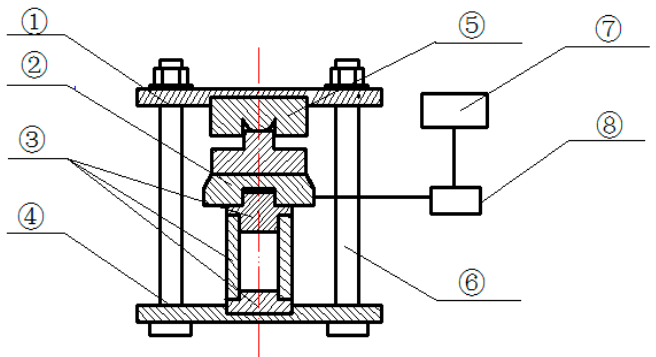
Figure 1. Schematic diagram of the expansion stress test apparatus: ① top plate, ② sensor, ③ sample mold, ④ bottom plate, ⑤ anti-load measuring head, ⑥ constrained screw, ⑦ data acquisition system, and ⑧ transmitter.